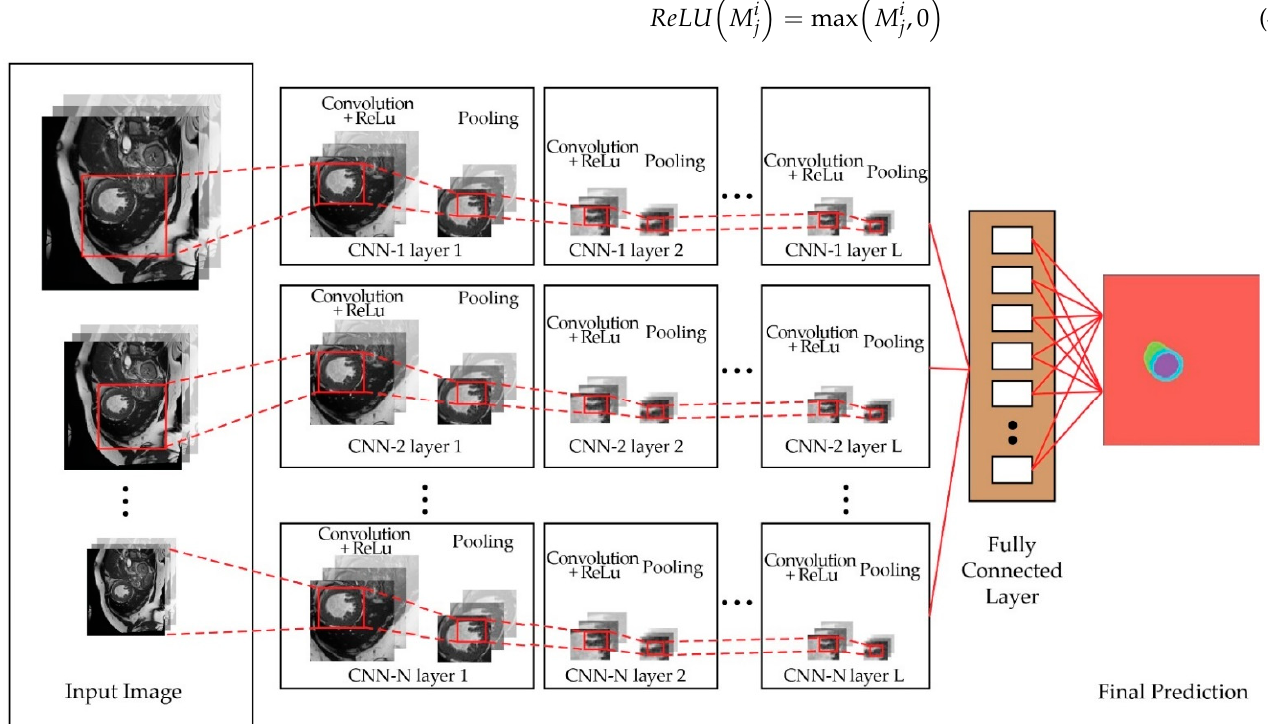
Figure 3. Multiscale CNN, defined as a network with multiple distinct CNN networks with various contextual input sizes that run concurrently, whereby the outputs are combined at the end of the network to obtain rich multiscale semantic features.